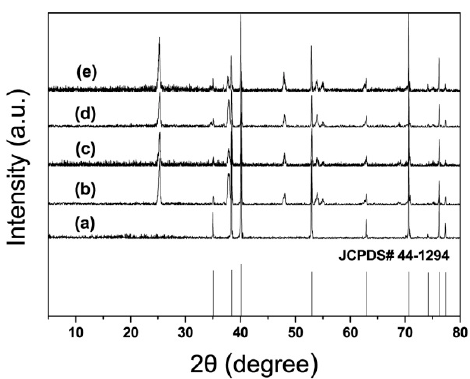
Figure 1. XRD patterns of ( a ) Ti foil; ( b ) TiO 2 NTs / Ti; ( c ) Pt / TiO 2 NTs / Ti; ( d ) IrO 2 / TiO 2 NTs / Ti; ( e ) Pt-IrO 2 / TiO 2 NTs / Ti.